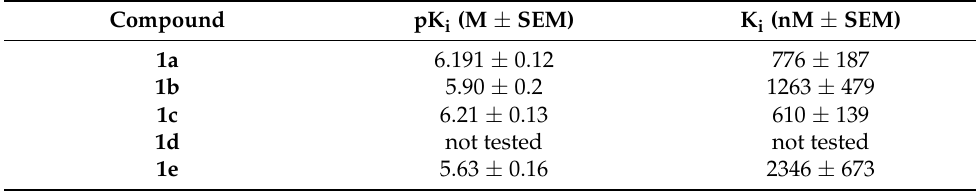
Table 5. 5-HT 2A receptor binding of investigated